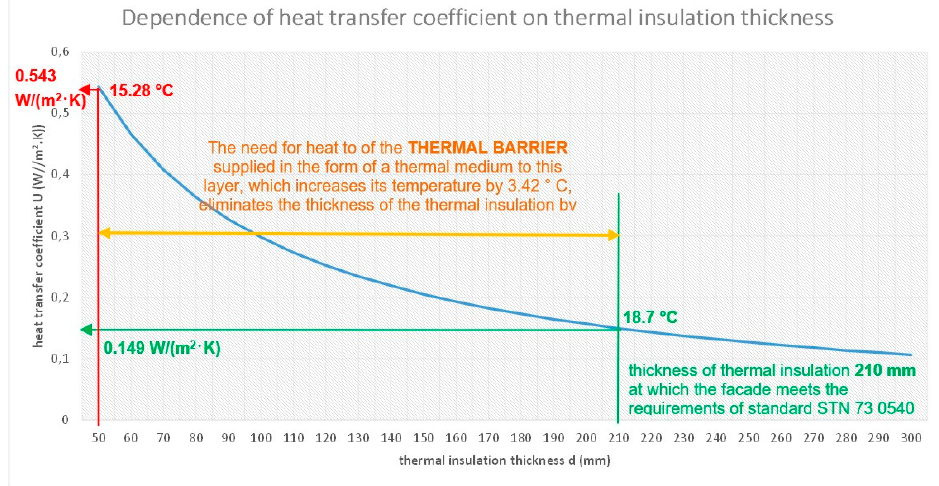
Figure 4. Dependence of heat transfer coefficient on thermal insulation thickness.